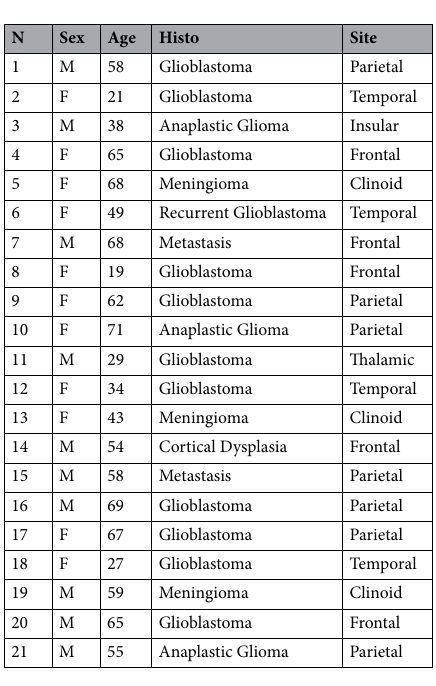
Table 1. Patients description including tumors histotypes.